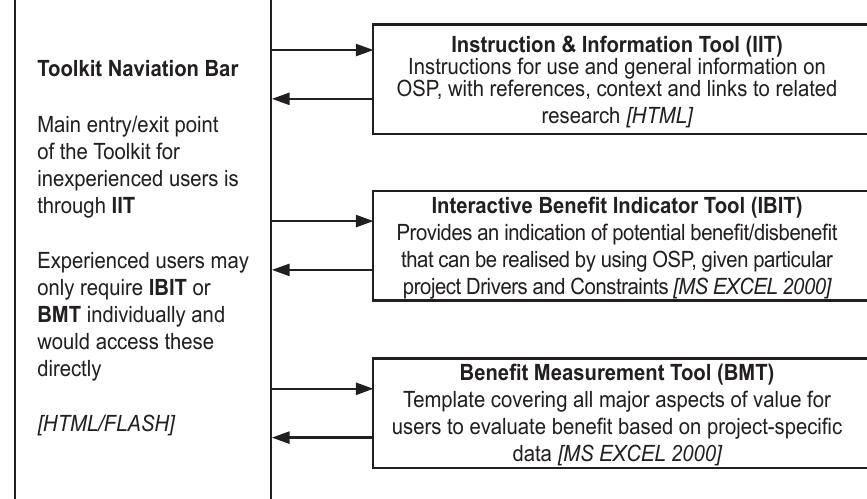
Figure 1: Schematic outline of the IMMPREST toolkit (SOURCE: Blismas et al., 2003b)